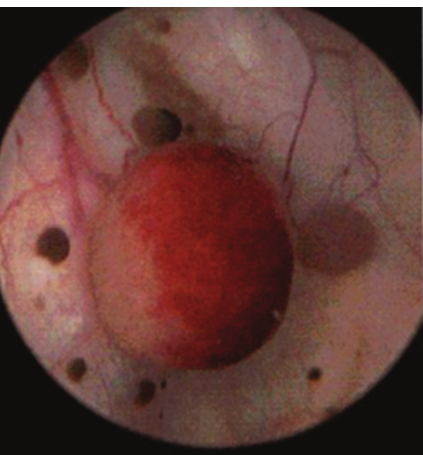
Figure 1: Cystoscopy demonstrating several malignant melanoma lesions throughout the bladder.